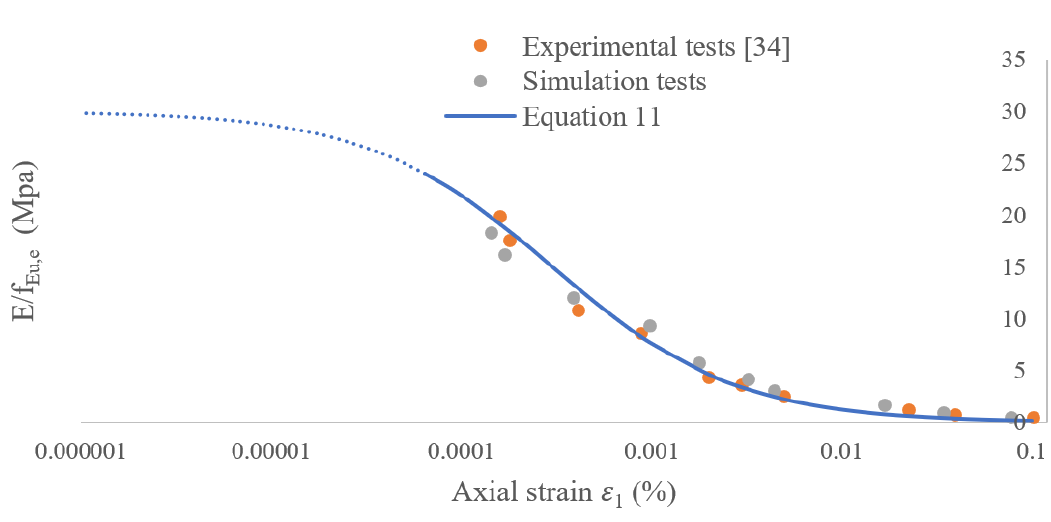
Figure 3. Calibration of parameters 𝑪 and 𝝀 .